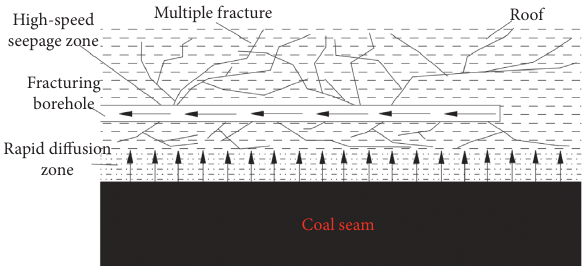
Figure 1: Schematic diagram of roof multistaged fracturing in outburst coal